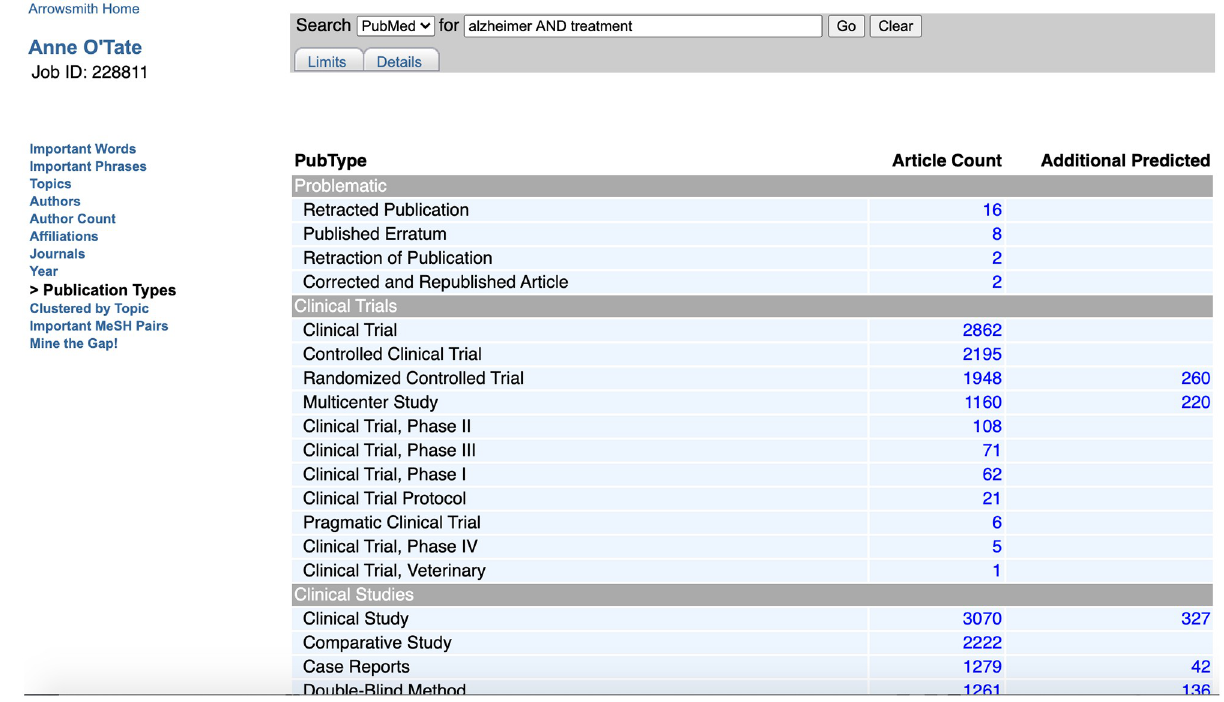
Fig 6. Screenshot showing a sample query with both indexed and predicted Randomized Controlled trial articles displayed. The query [Alzheimer AND treatment] was further processed using the Publication Types button, and the initial part of the display including Problematic Publications and Clinical Trials is shown. Note that 1948 articles are indexed under Randomized Controlled Trials [PT], whereas another 260 articles are predicted to be RCTs as well according to our model.